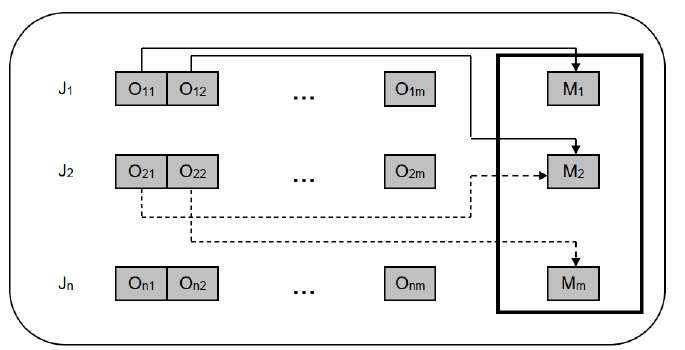
Figure 1. Representation of a Job Shop scheduling problem (based on Beirão proposal